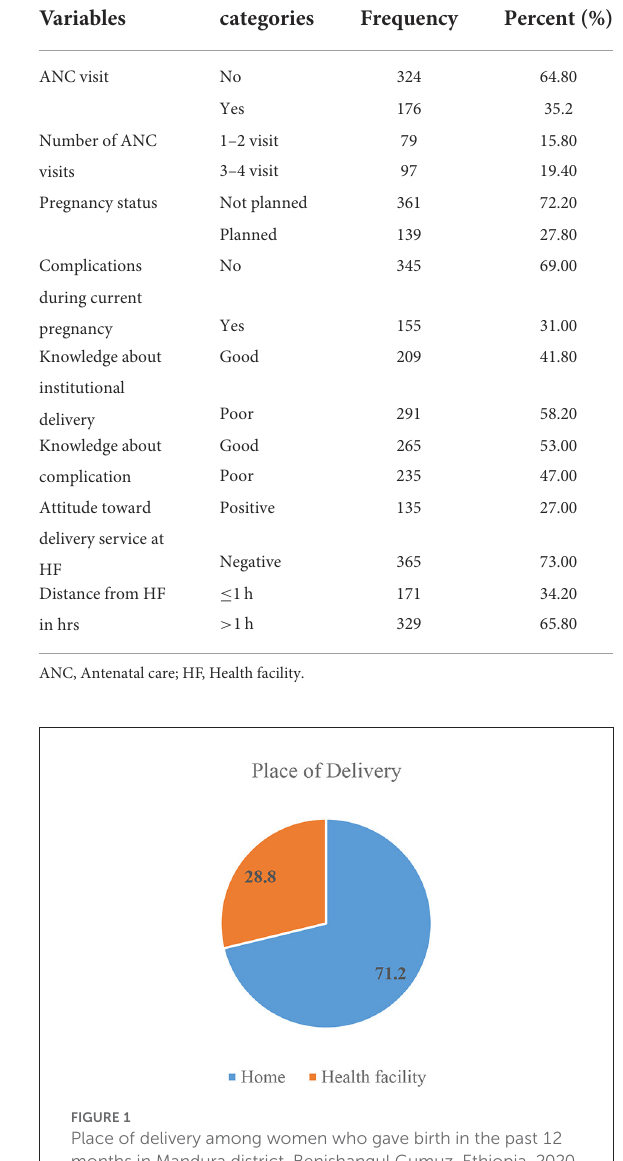
TABLE 2 Obstetric conditions of women who gave birth in the past 12-months in Mandura district, Benishangul Gumuz region, Ethiopia, 2020 ( n = 500).